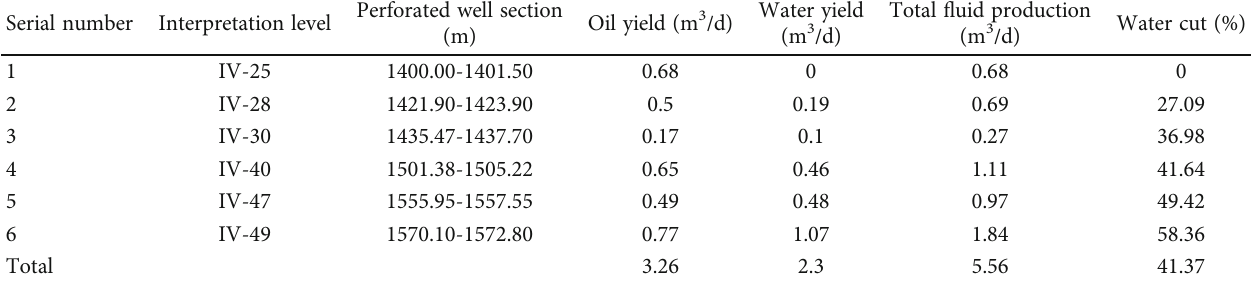
Table 7: Well 13-1-2 interpretation result